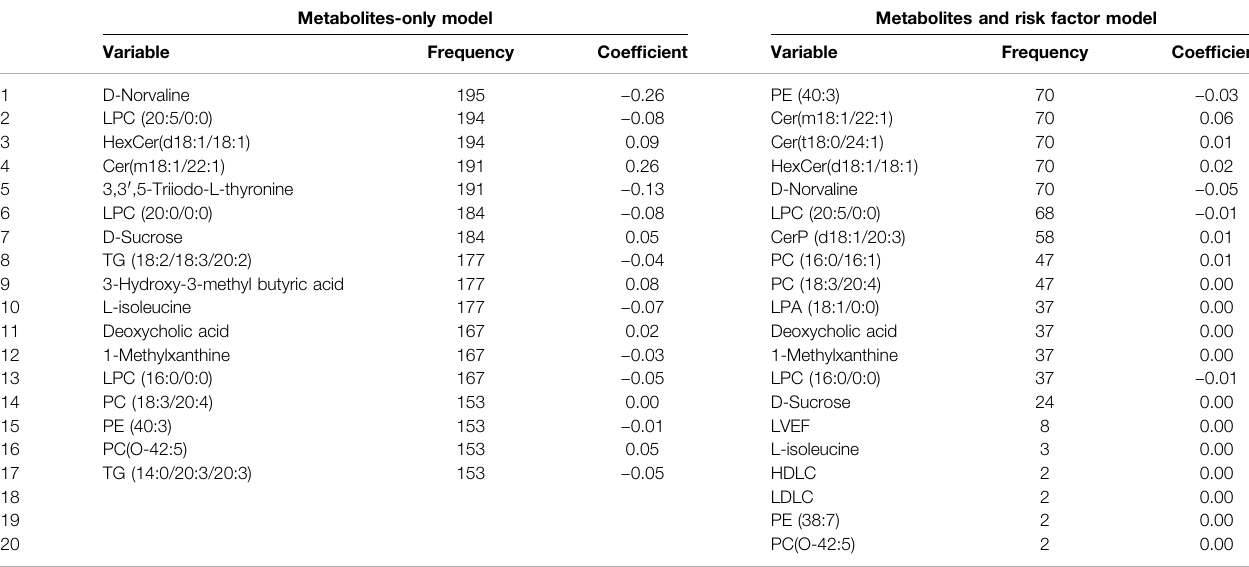
TABLE 4 | Feature inclusion frequency using LASSO based feature selection for UA (vs. SCAD). Metabolites-only